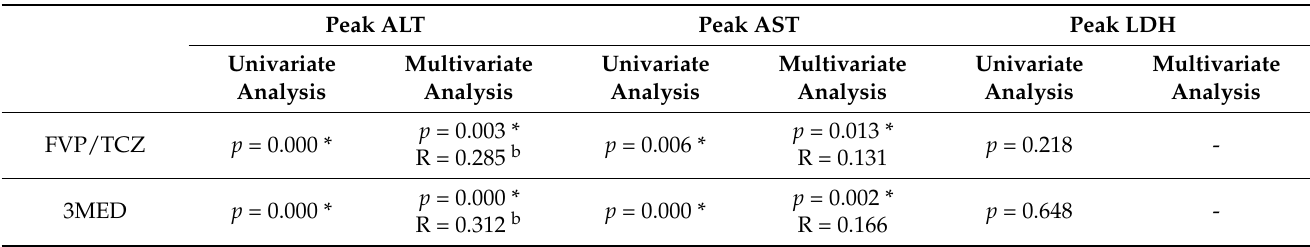
Table 4. Cont. Peak ALT Peak AST Peak LDH Univariate Multivariate Analysis Analysis